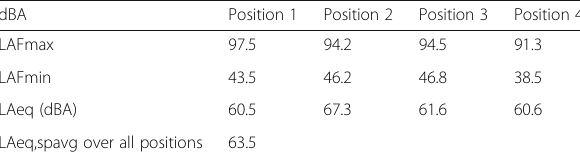
Table 1 (abstract 0212). Maximum (LAFmax), minimum (LAFmin), equivalent continuous (LAeq) and spatial average over all positions continuous equivalent (LAeq,spavg) soundlevels